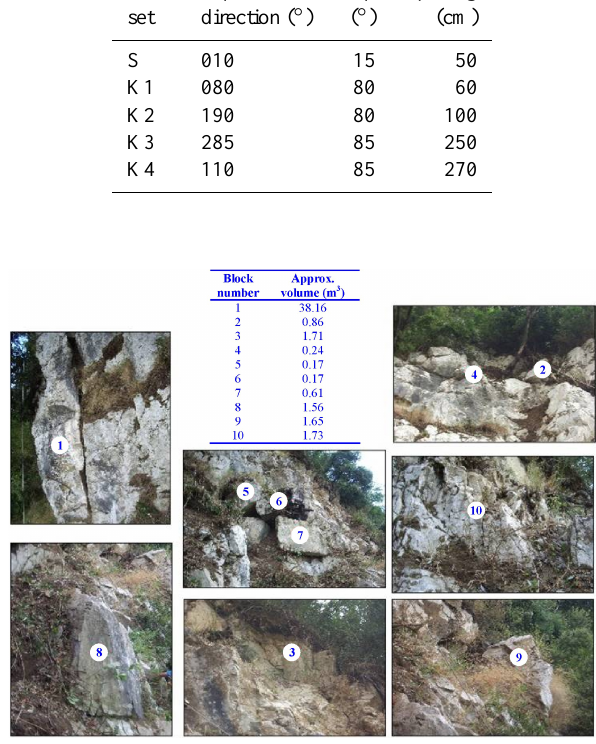
Fig. 8. Potentially unstable blocks, and related volumes, outcrop- ping on the